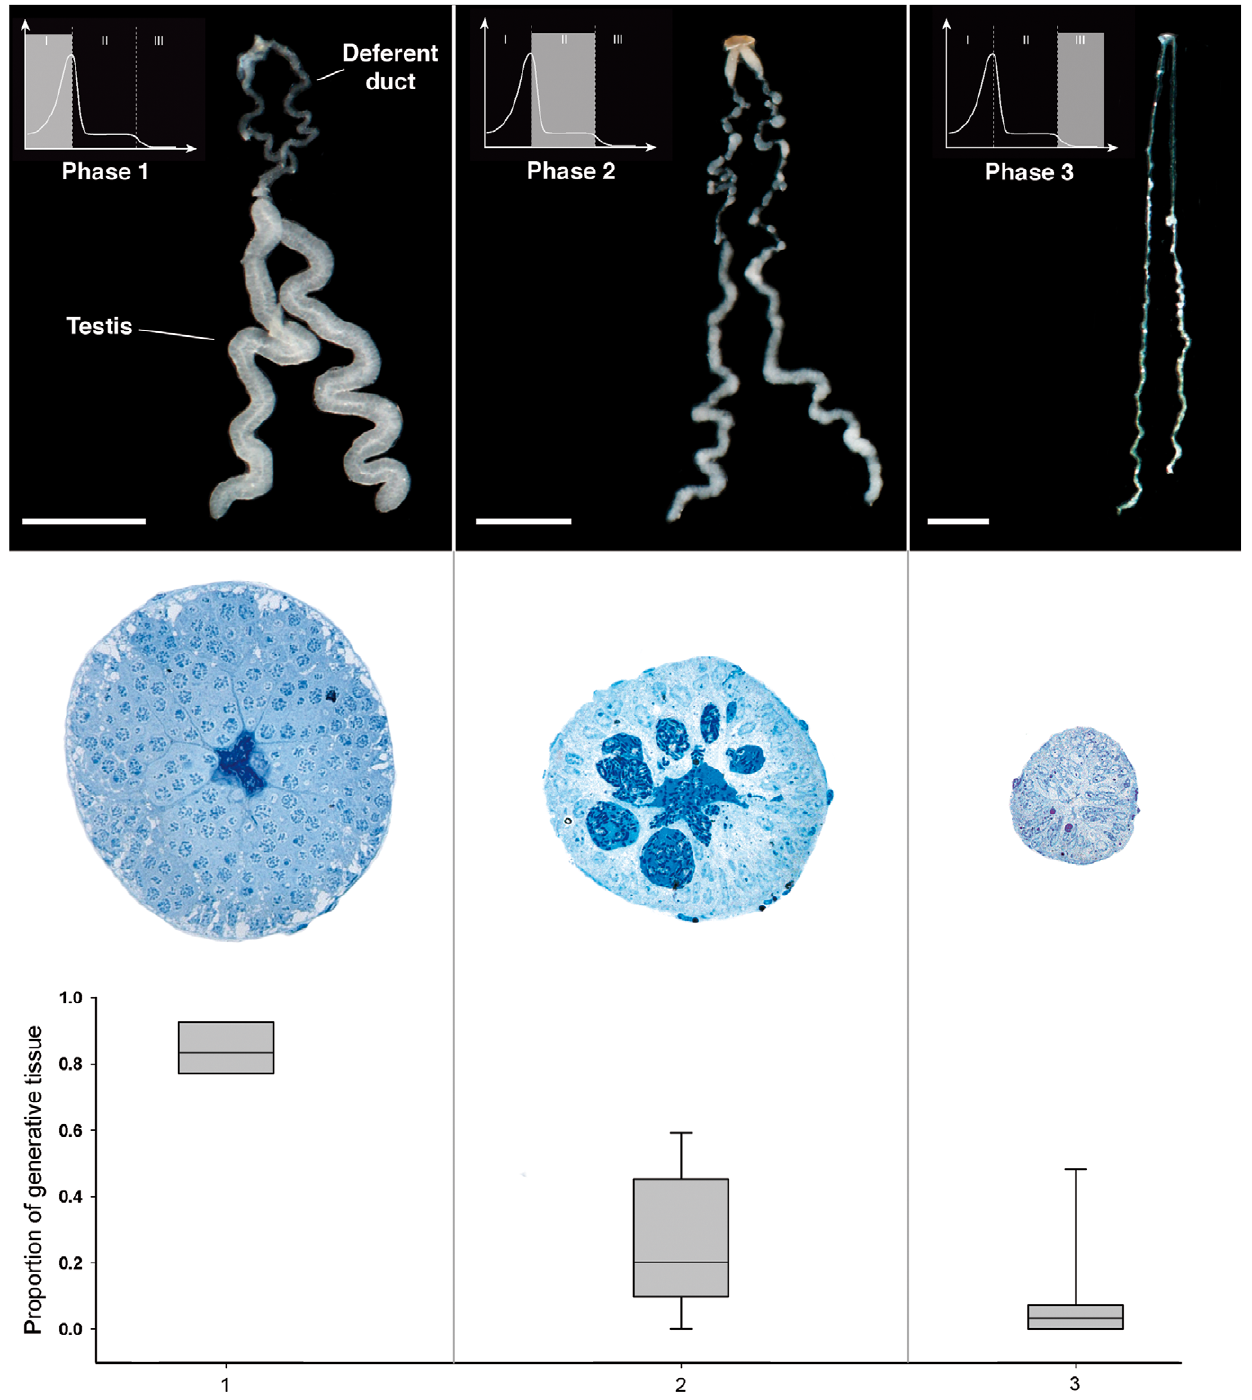
Figure 3. Development of the male genital system in Nephilaclavipes . Three phases in the development of the male genital system (left to right) characterized by a dorsal view of the whole genital system (top, scale: 1 mm), a stained cross-section of the testis (middle), and the analysis of the proportion of the generative tissue in testis (bottom; Kruskal-Wallis Test, one-way; X 2 =17.26, P , 0.0002).